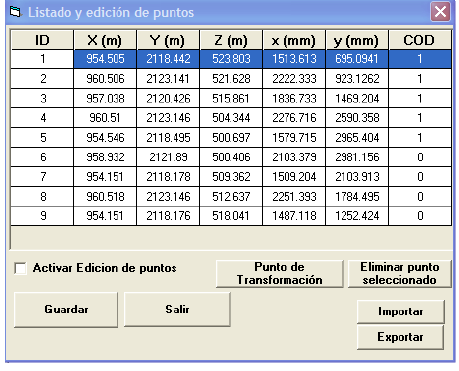
Figure 3. Points edition window